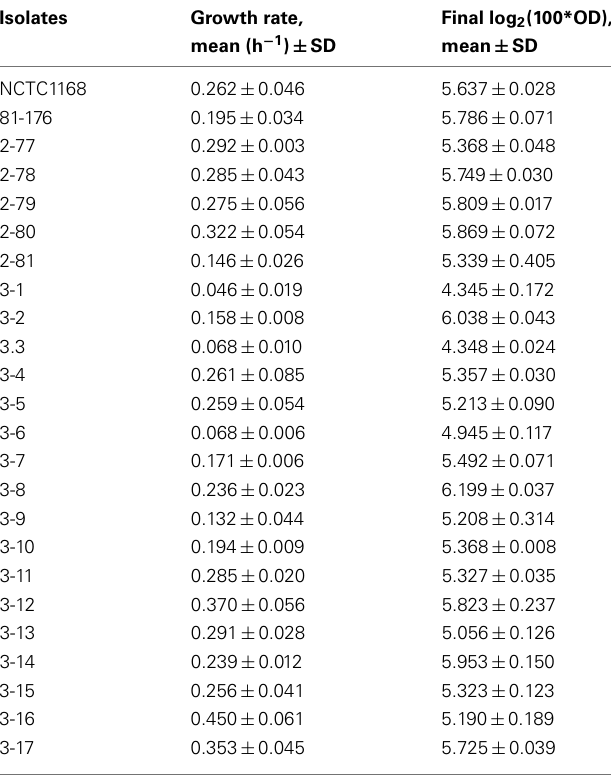
Table 2 | Growth of C. jejuni isolates.